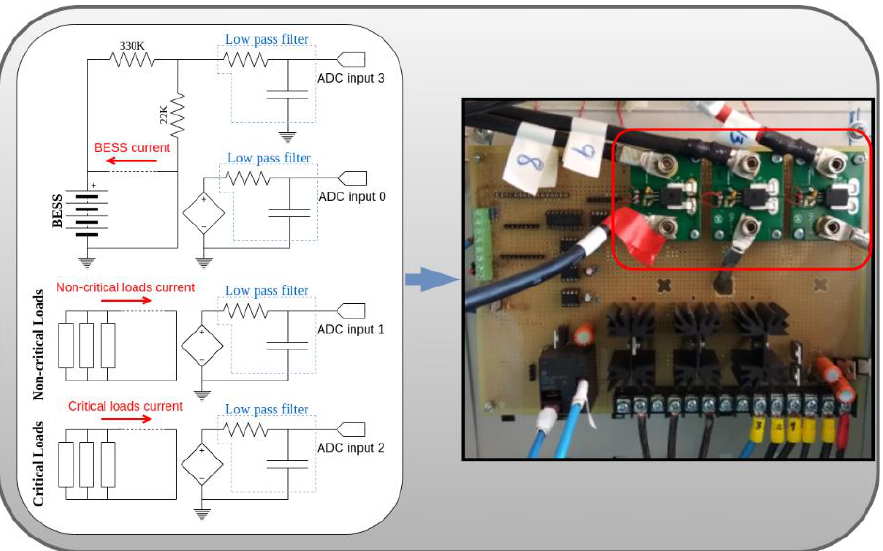
Figure 4. Electronics for the measurement of currents and voltages in BESS, non-critical and criti- cal loads.